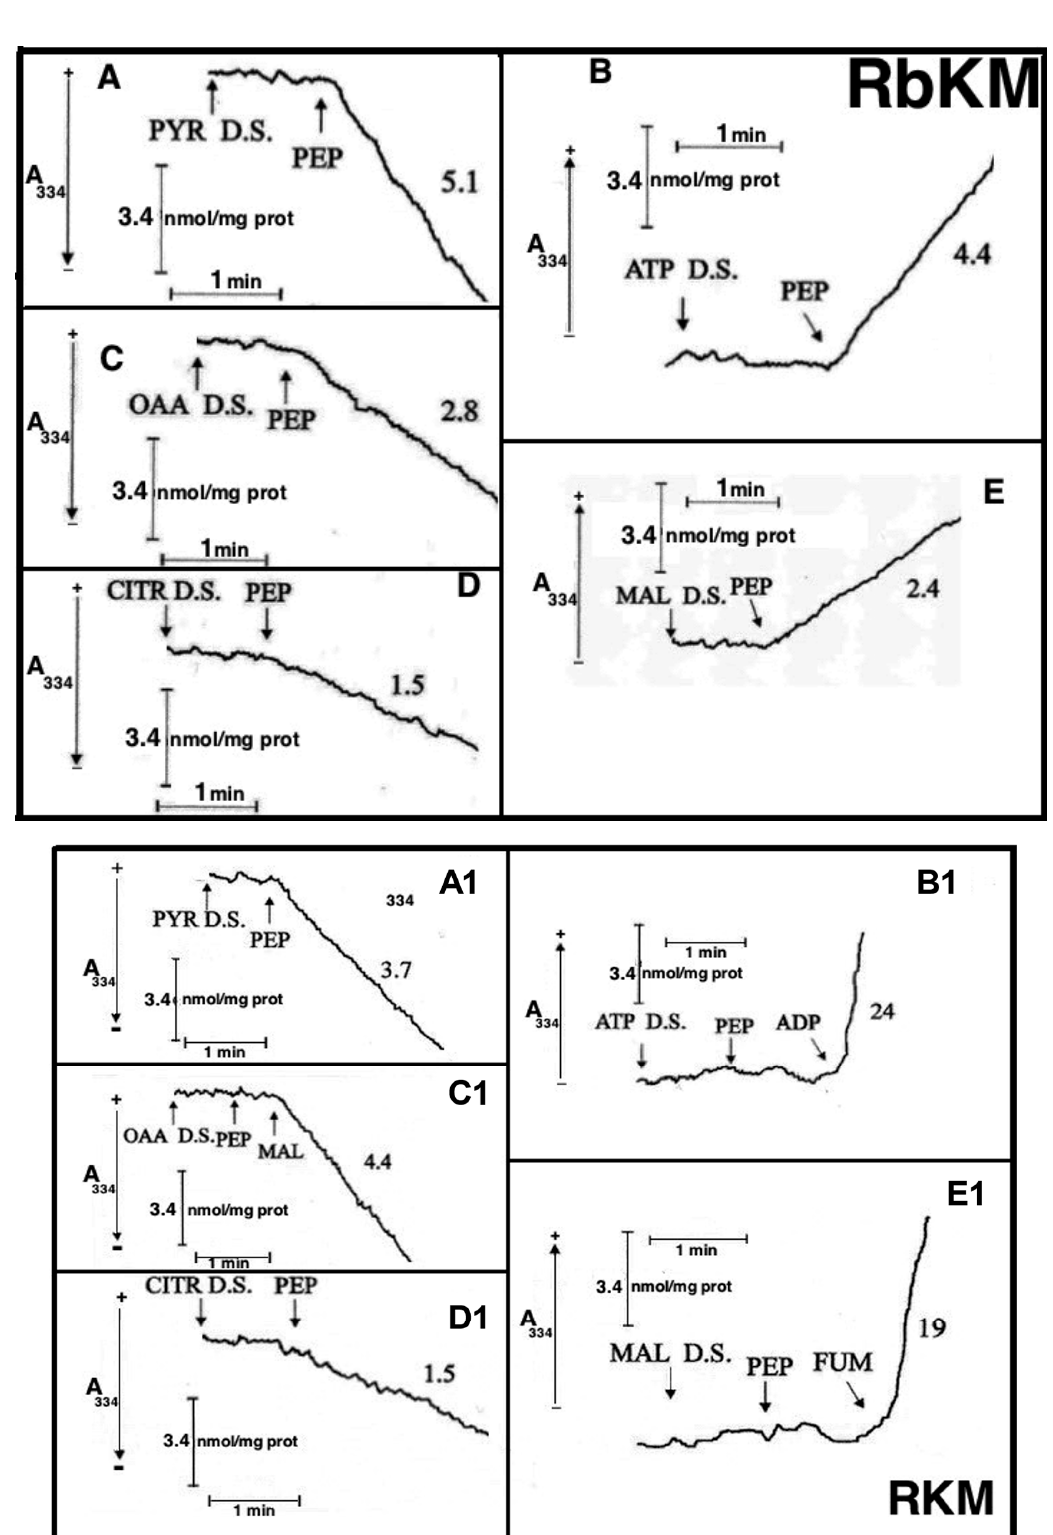
Figure 8. Appearance of pyruvate (PYR) ( A ), ATP ( B ), oxaloacetate (OAA) ( C ), citrate (CITR) ( D ), and malate (MAL) ( E ) in the extramitochondrial phase space induced by PEP addition to rabbit kidney mitochondria (RbKM) and appearance of PYR ( A1 ), ATP ( B1 ), OAA ( C1 ), CITR ( D1 ), and MAL ( E1 ) in the extramitochondrial phase space induced by the addition of PEP, ADP, MAL, and fumarate (FUM) to rat kidney mitochondria (RKM). From [12]. With permission from Aracne Editrice,